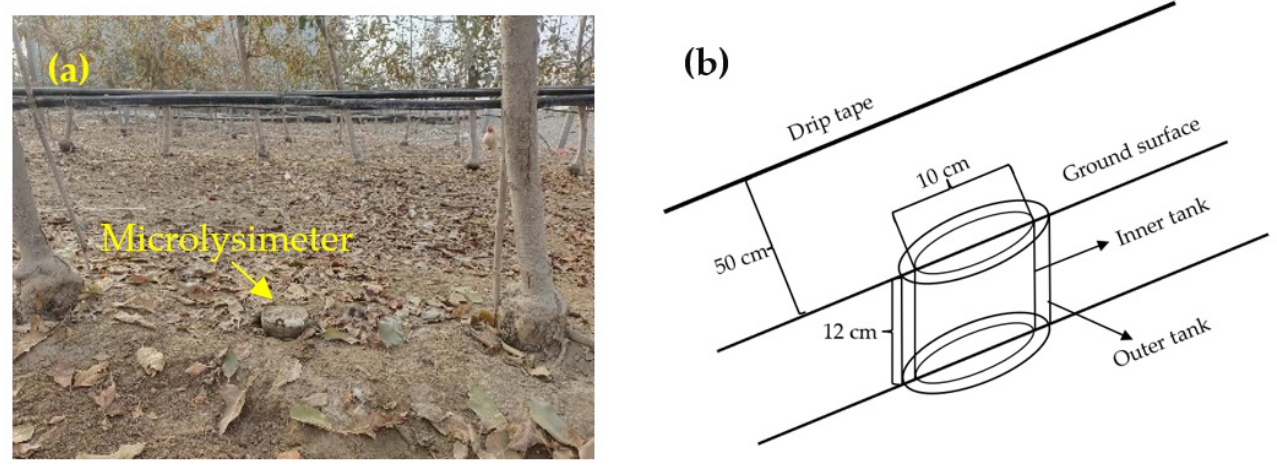
Figure 3. Microlysimeter used for soil evaporation measurement. ( a ) Location of microlysimeter; ( b ) diagram of microly- simeter.